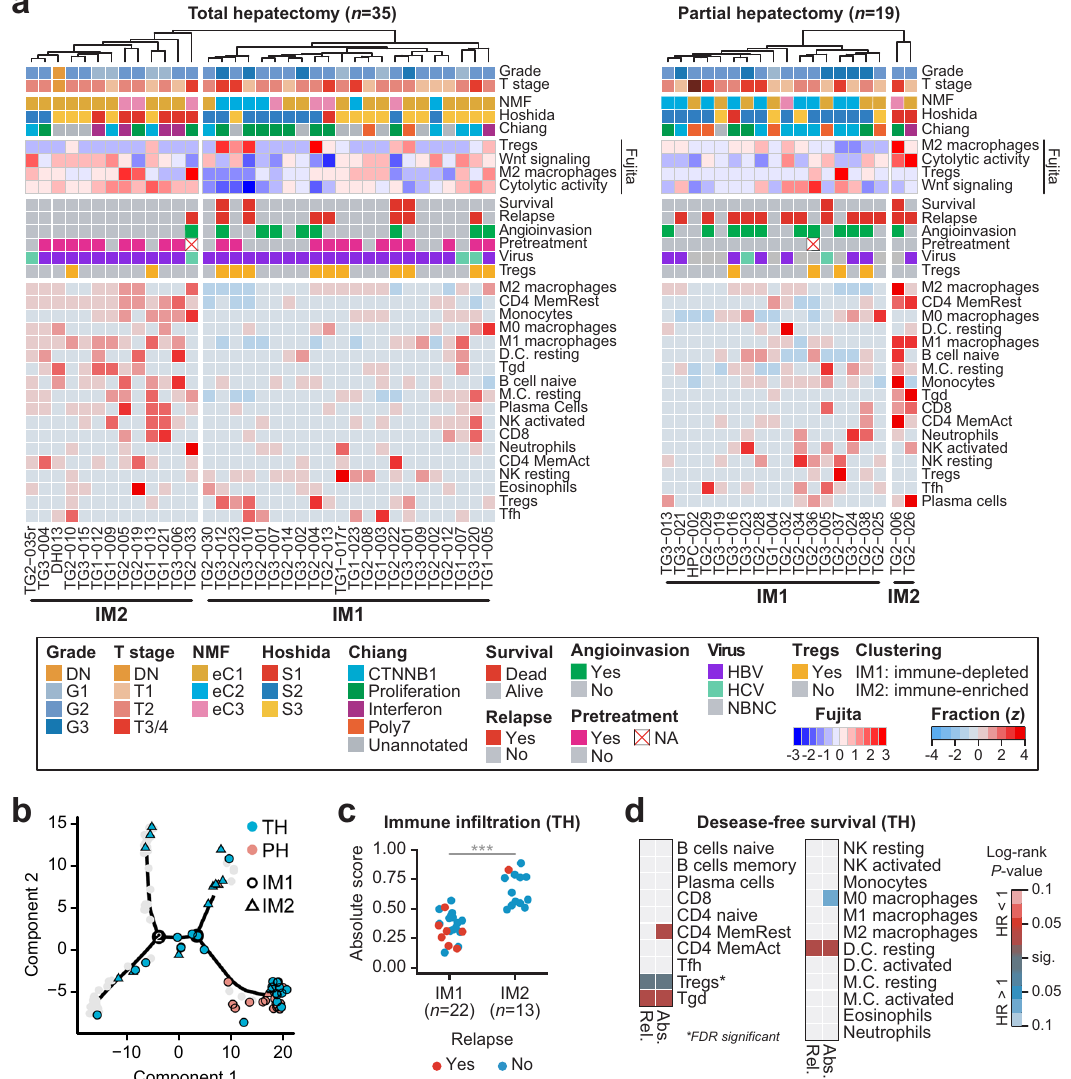
Fig. 4 Identi fi cation of immune cell types associated with clinical outcomes in total hepatectomy. a Clustering of immune cell fractions in TH ( n = 35; left) and PH ( n = 19; right). Row dendrograms are not shown. Naive CD4 T cells and memory B cells in TH and eosinophils in PH were not inferred across all samples and were therefore excluded. Color codes are speci fi ed in the box. b Two immune clusters, IM1 and IM2, on the trajectory identi fi ed in Fig. 1c. Different colors and shapes indicate the operational method and immune cluster, respectively. c Comparison between absolute scores of the IM1 and IM2 clusters in TH. Welch ’ s t -test, *** P < 0.001. d Clinical associations of 22 immune cell types. Abs. absolute score, Rel. relative fraction. The bar color represents the signi fi cance of log-rank P values. When a high fraction of cells is correlated with a poor outcome, the appropriate box is colored blue (lower half). When a high fraction of cells is correlated with a good outcome, the box is colored red (upper half). *Signi fi cant after FDR clustering, in contrast to the expression-based clustering, was able and 5) and state 5, which showed a higher load of immune to identify elevated immune signatures that could be ignored by in fi ltration is preferentially found in PL-IM3 and 4. In contrast, other types of molecular clustering. immune-depleted state 1 is prevalent in PL-IM1 and 2. These We next sought to identify speci fi c immune cell types nontumor immune clusters were independent of those de fi ned in correlated with clinical outcomes. Of the 22 immune cell types paired tumor samples. Macrophages, which were the most analyzed, in fi ltration of Tregs was found to be a strong indicator of abundant cell type in fi brosis/cirrhosis samples, showed dynamic tumor relapse in TH after false discovery rate (FDR) correction changes during HCC development (Fig. 3c and Supplementary Fig. ( FDR < 6.39 × 10 − 3 for the absolute score; FDR < 1.62 × 10 − 3 for the 3b). Two types of differentiated macrophages with opposing functions, M1 and M2, were enriched in PL-IM3 and PL-IM2, relative fraction; Fig. 4d) and in multivariate analysis ( P < 0.039; respectively, although these two immune clusters are mainly Supplementary Fig. 6a). The number of FOXP3 + cells determined associated to a single NMF cluster, PL2 (Supplementary Fig. 5a, c). by IHC also showed a positive correlation with the absolute Likewise, gene expression-based clustering again failed to fraction of Tregs ( P = 0.043; Supplementary Fig. 6b, g). Tregs separate immune-enriched from immune-depleted samples are known to be the main source of immune exhaustion and are (Supplementary Fig. 5a, d, NMF PL1 ~ 3). Overall, our immune cell linked to poor outcomes in human cancers, including HCC 27 – 31 .